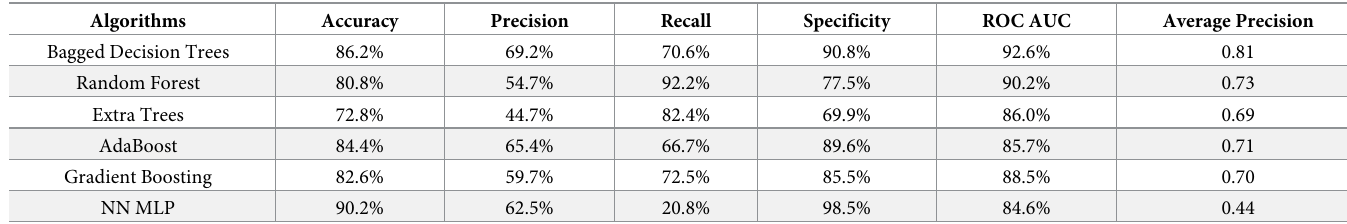
Table 3. Performance metrics of algorithms.